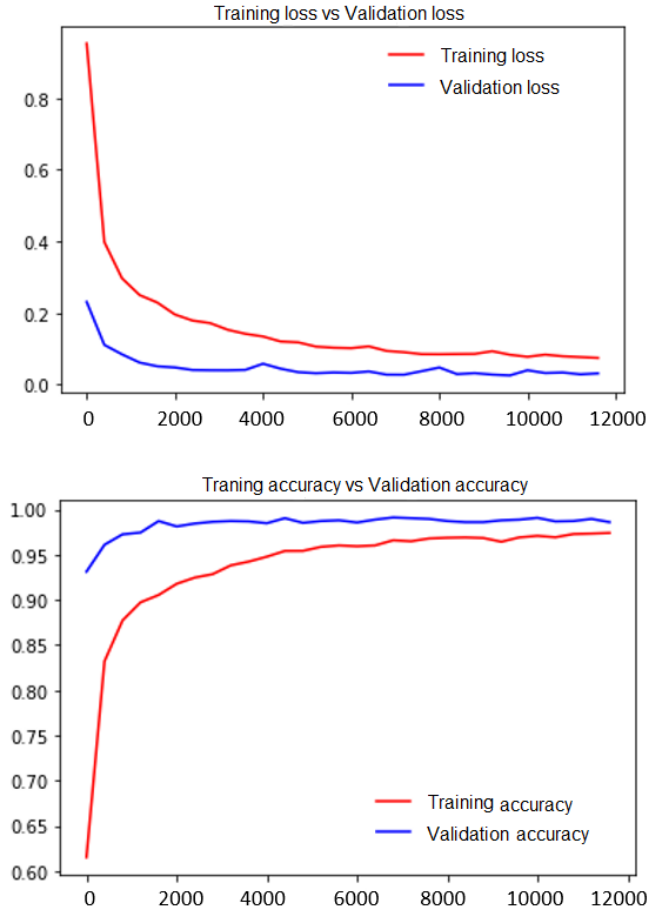
Figure 8. Computational performance on training